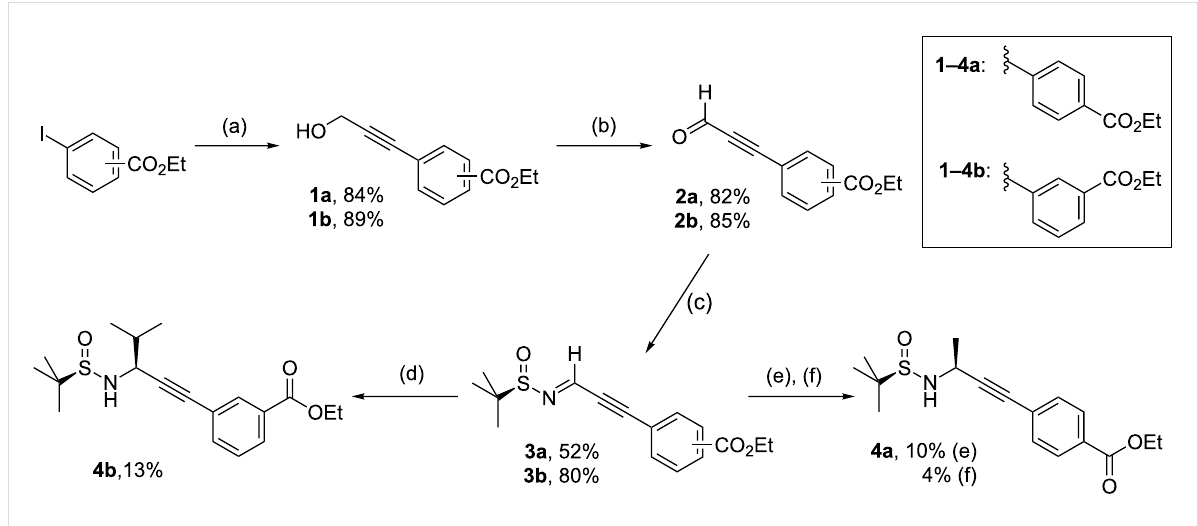
Figure 4: Synthesis of propargylamines 4a and 4b by introducing the side chain as nucleophile. (a) HC ≡ CCH 2 OH, Cl 2 Pd(PPh 3 ) 2 (1 mol %), CuI (2 mol %), THF/piperidine (3:1), rt, 2 h. (b) (COCl) 2 , DMSO, NEt 3 , − 78 °C, DCM. (c) ( R )- tert- Butyl sulfinamide (( R ) -1 ), CuSO 4 , DCM, rt, 3 d (see